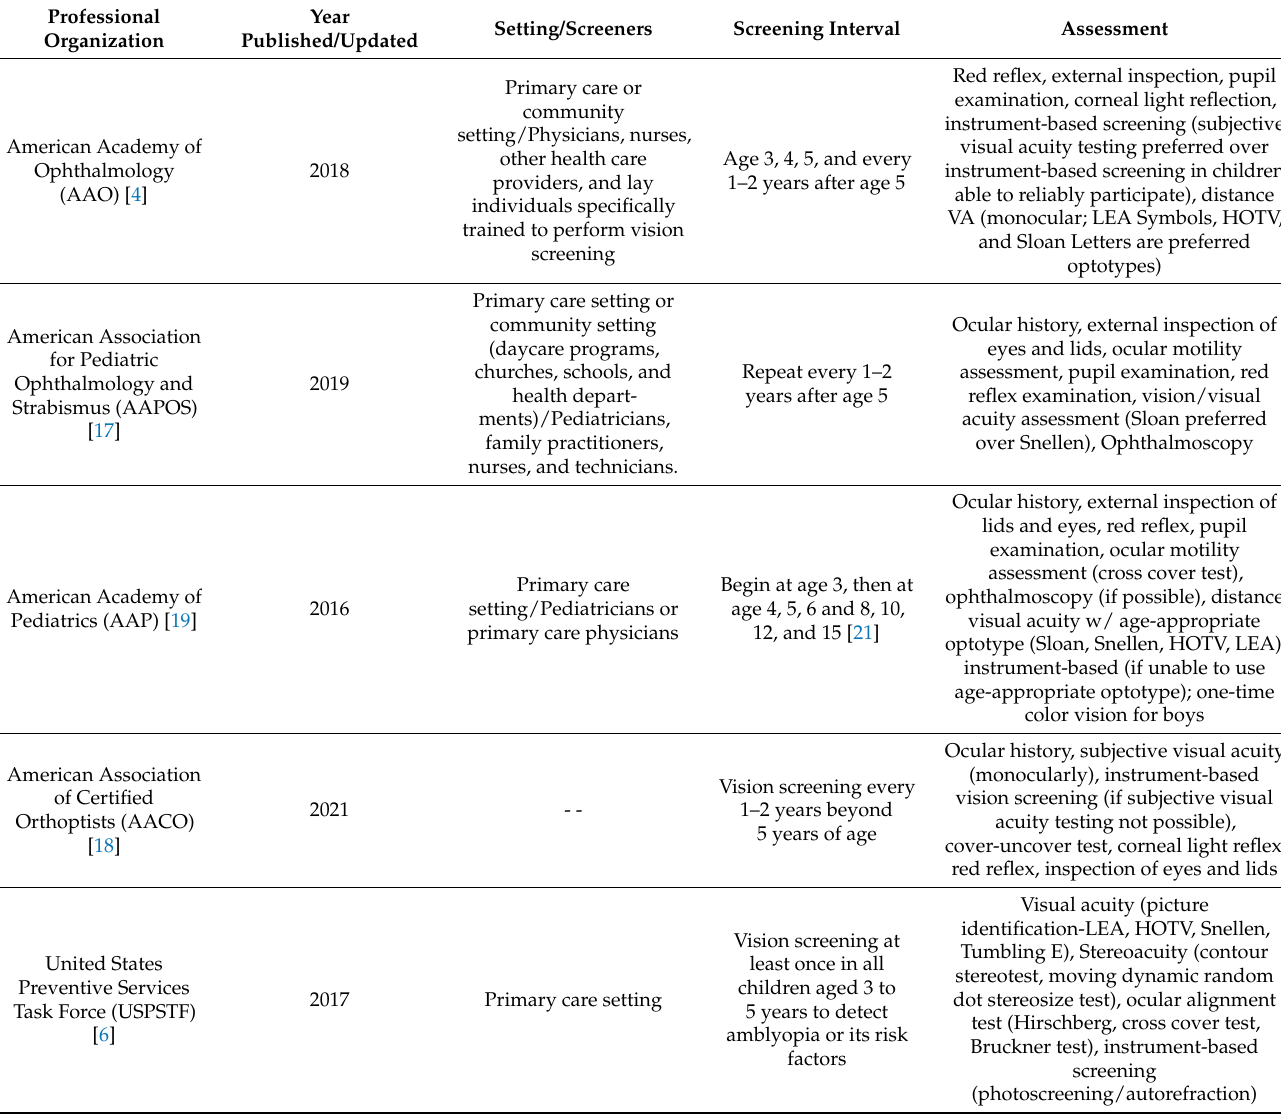
Table 1. Summary of Professional Organization Vision Screening